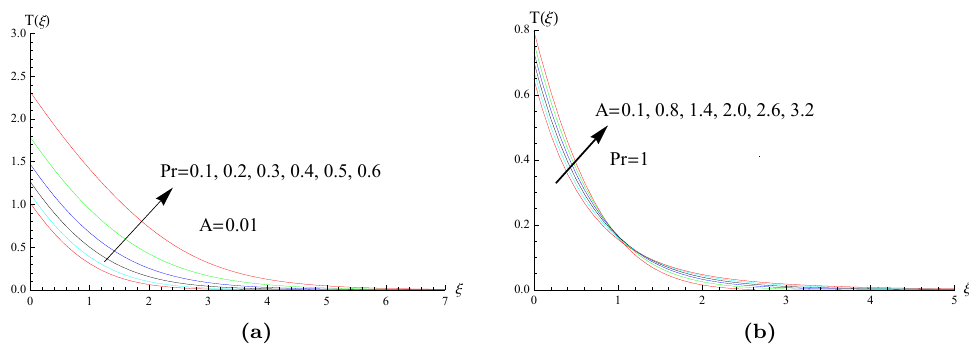
Figure 3: Behavior of temperature profile against pertinent fluid parameters. ( a ) variation of Pr; ( b ) variation of